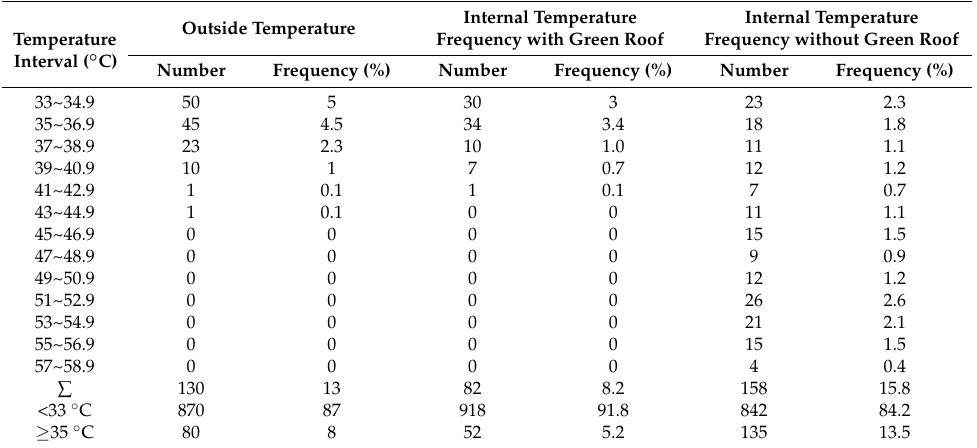
Table 1. Frequency distribution of outside temperature and internal surface temperature. Internal Temperature Internal Temperature Outside Temperature Frequency with Green Roof Frequency without Green Roof Temperature Interval ( ◦ C) Number Frequency (%) Number Frequency